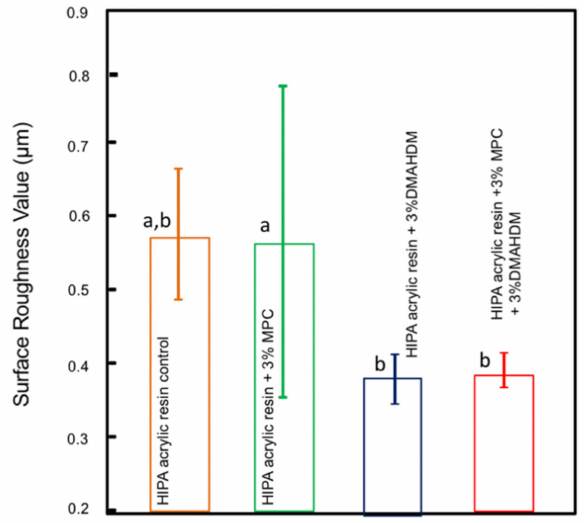
Figure 4. Surface roughness of acrylic resin; similar letters indicate statistical similarity (Tukey’s test, p < 0.05).